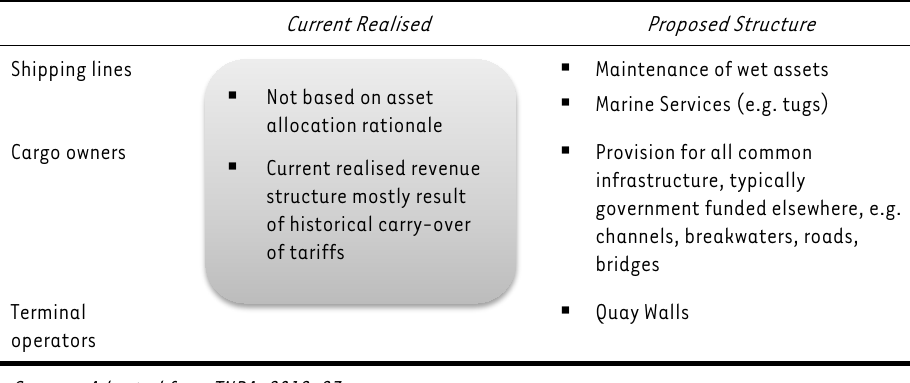
Current and Proposed Structure of Required Revenue